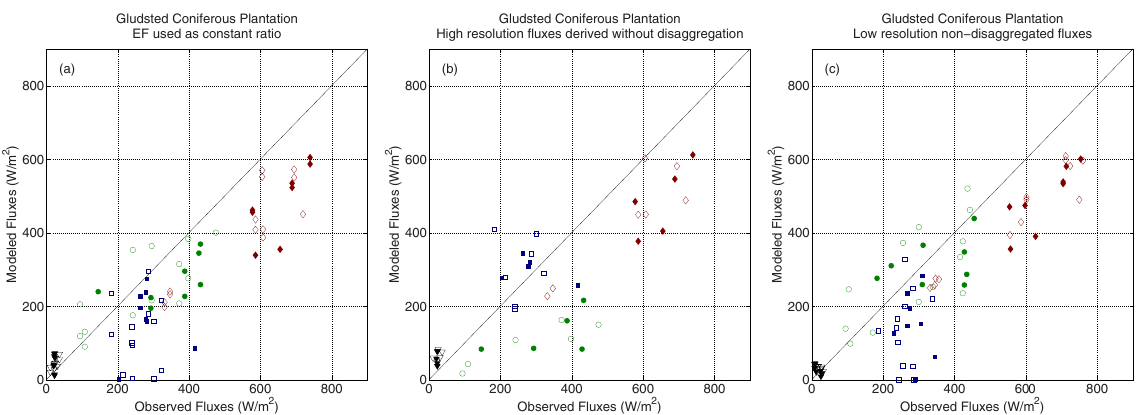
Figure 9. Comparison of modelled and EC measured fluxes at the Gludsted coniferous plantation with meteorological inputs provided by the ERA-Interim data set. Modelled fluxes are instantaneous at the time of satellite overpass and observed fluxes are 30min averaged EC measurements. The three panels show: (a) fluxes disaggregated using the evaporative fraction method, (b) high-resolution fluxes derived with TSEB model without disaggregation, (c) low-resolution, non-disaggregated fluxes modelled with DTD. The fluxes modelled at 30m resolution (panels (a) and (b) ) are aggregated to EC footprint. Rectangles represent LE, circles represent H , triangles represent G and diamonds represent R n . Empty symbols indicate aggregated fluxes where pixels comprising 70% of EC footprint were present (S70 set), and full symbols where in addition there were no missing Landsat pixels within the MODIS pixels (S100